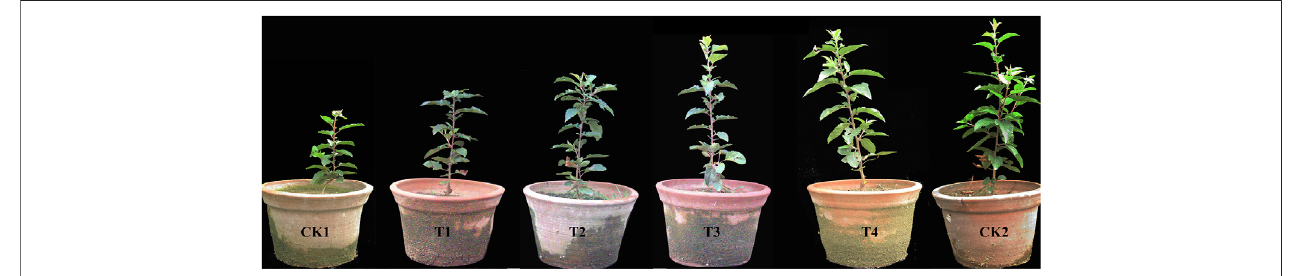
FIGURE 8 | Growth of M. hupehensis (Pamp.) Rehd. var. Pingyiensis after different treatments. CK1: control, CK2: high standard control, T1:foliar spraying, T2: foliar soaking, T3: root soaking, T4: soil